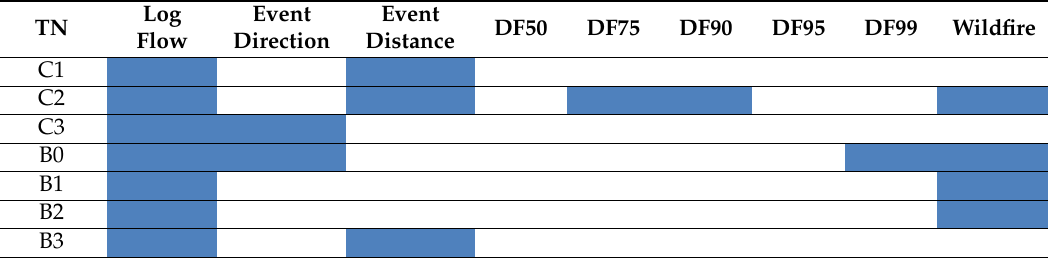
Table 7. Selected predictors for model predicting total